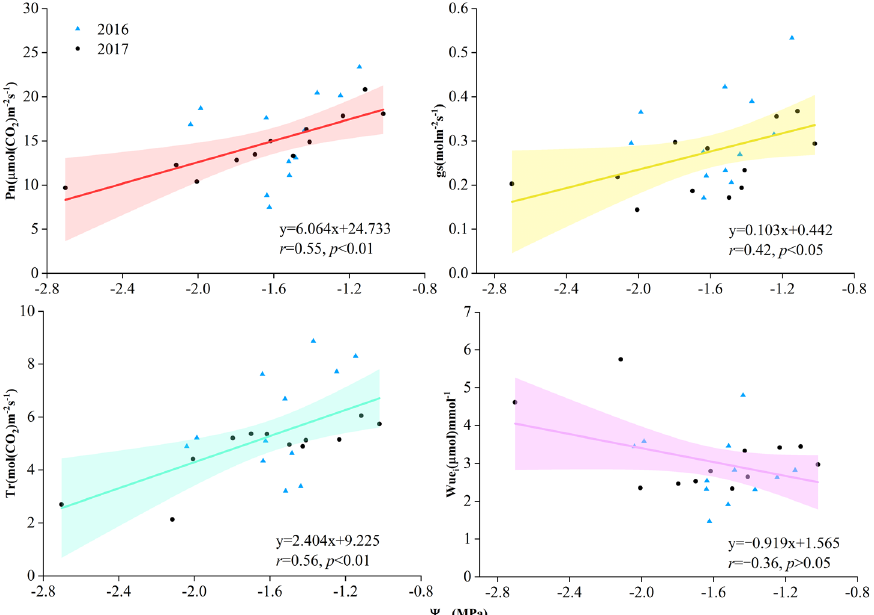
Figure 6. Relationship between leaf gas exchange and predawn stem water potential ( Ψ PL ) during the growing season in 2016 and 2017. r indicates correlation coefficients between each pair of tested parameters. Pn means net photosynthesis rate, gs means stomatal conductance, Tr means transpiration rate, and Wue means water-use efficiency.